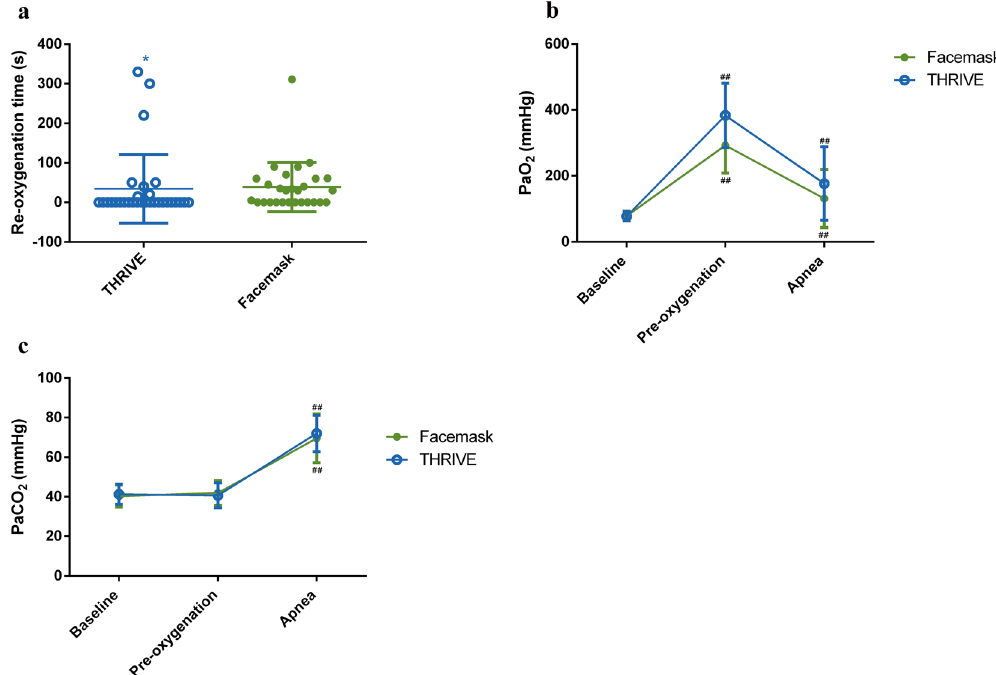
Figure 3. Re-oxygenation time ( a ), PaO 2 ( b ) and PaCO 2 ( c ) in the THRIVE and facemask groups. THRIVE, transnasal humidified rapid insufflation ventilator exchange. * Statistically significantly different from the facemask group, P < 0.05. ** Statistically significantly different from the facemask group, P < 0.01 ## . Statistically significantly different from the baseline.